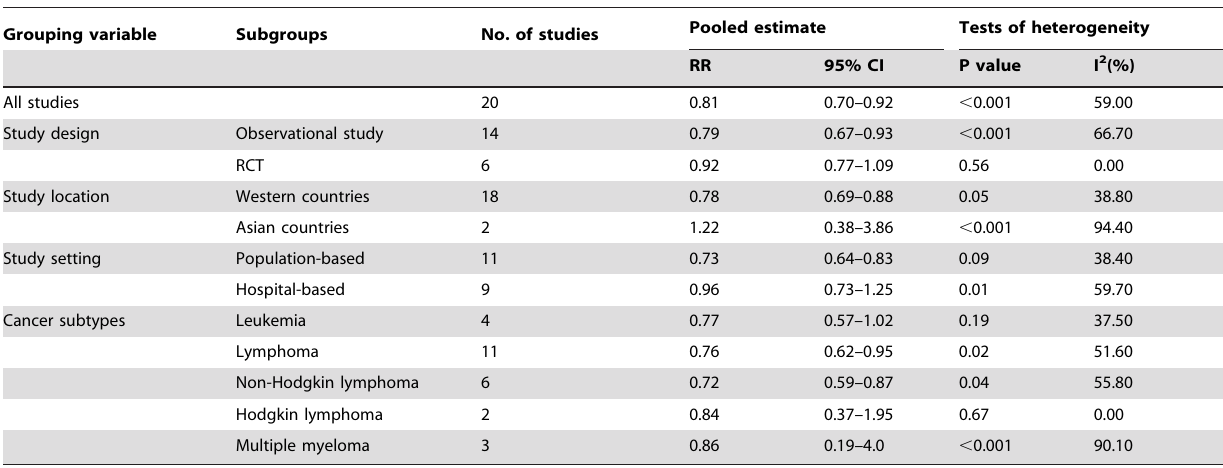
Table 2. Subgroup analysis of all